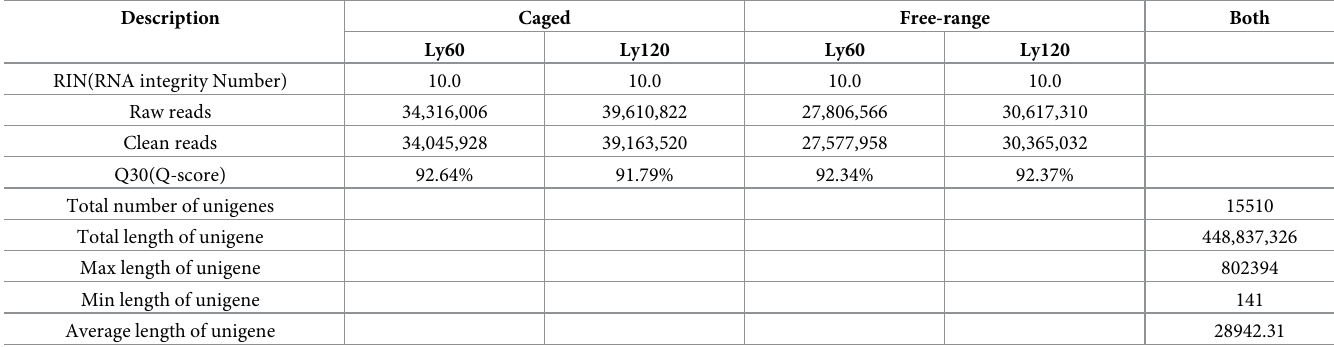
Table 3. Muscle transcriptome